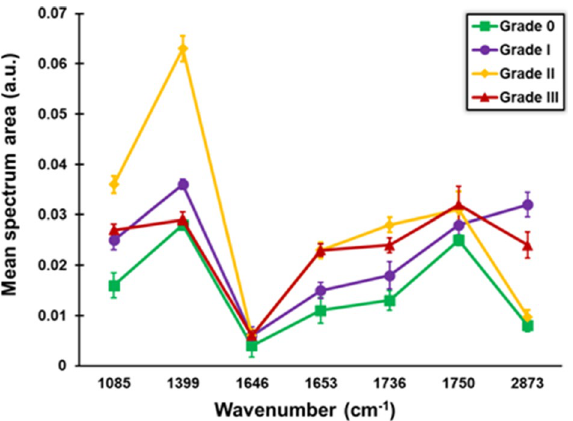
Figure 7. Concentration of lipid and phospholipid bonds in breast tissue biopsies. Data represent mean values of N = 15 areas for each case. Samples from two patients for each category were analyzed. Peaks 1,469 cm −1 , 2,848 cm −1 and 2,916 cm −1 were omitted from the graph due to their higher values. Error bars indicate SEM.